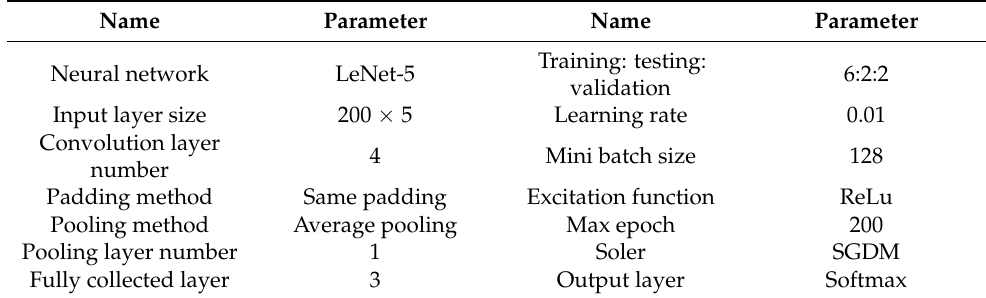
Table 3. The parameters in the 1D-CNNs